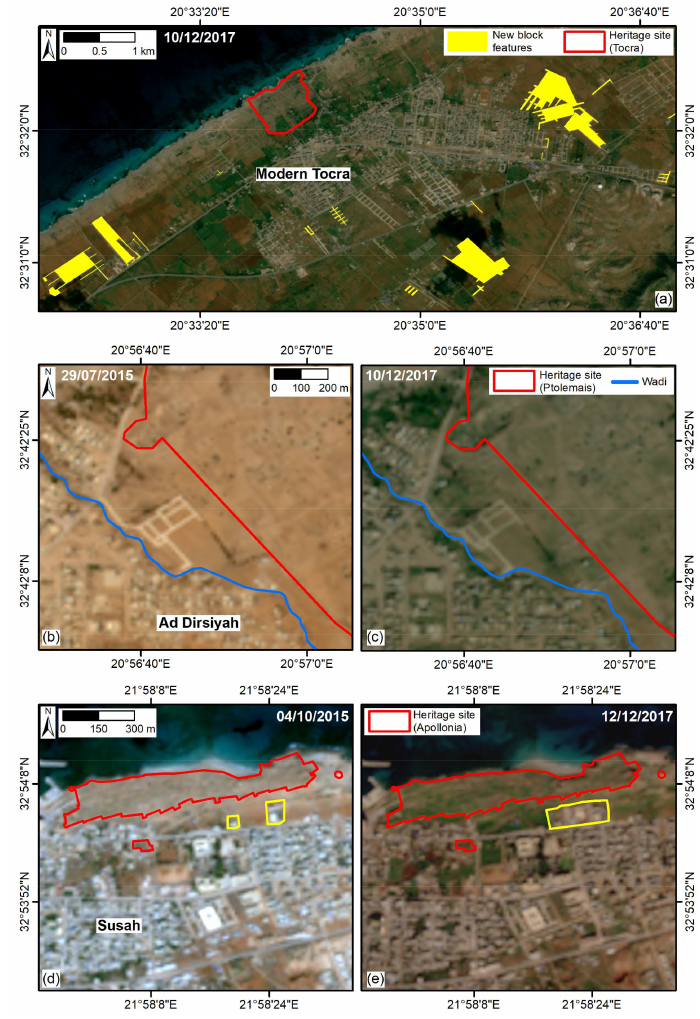
Figure 11. The condition on the ground in ( a ) Tocra, ( b,c ) Ptolemais and ( d,e ) Apollonia as captured by Sentinel-2 in 2015 versus 2017. ( a ) New block features (yellow polygons) are visible around the modern town of Tocra; ( b,c ) no change is detected over the existing block feature close to Ptolemais; ( d,e ) the development of previously vacant land lots along the southern boundary of Apollonia (yellow polygons). Copernicus Sentinel-2 images © 2015–2017 European Space